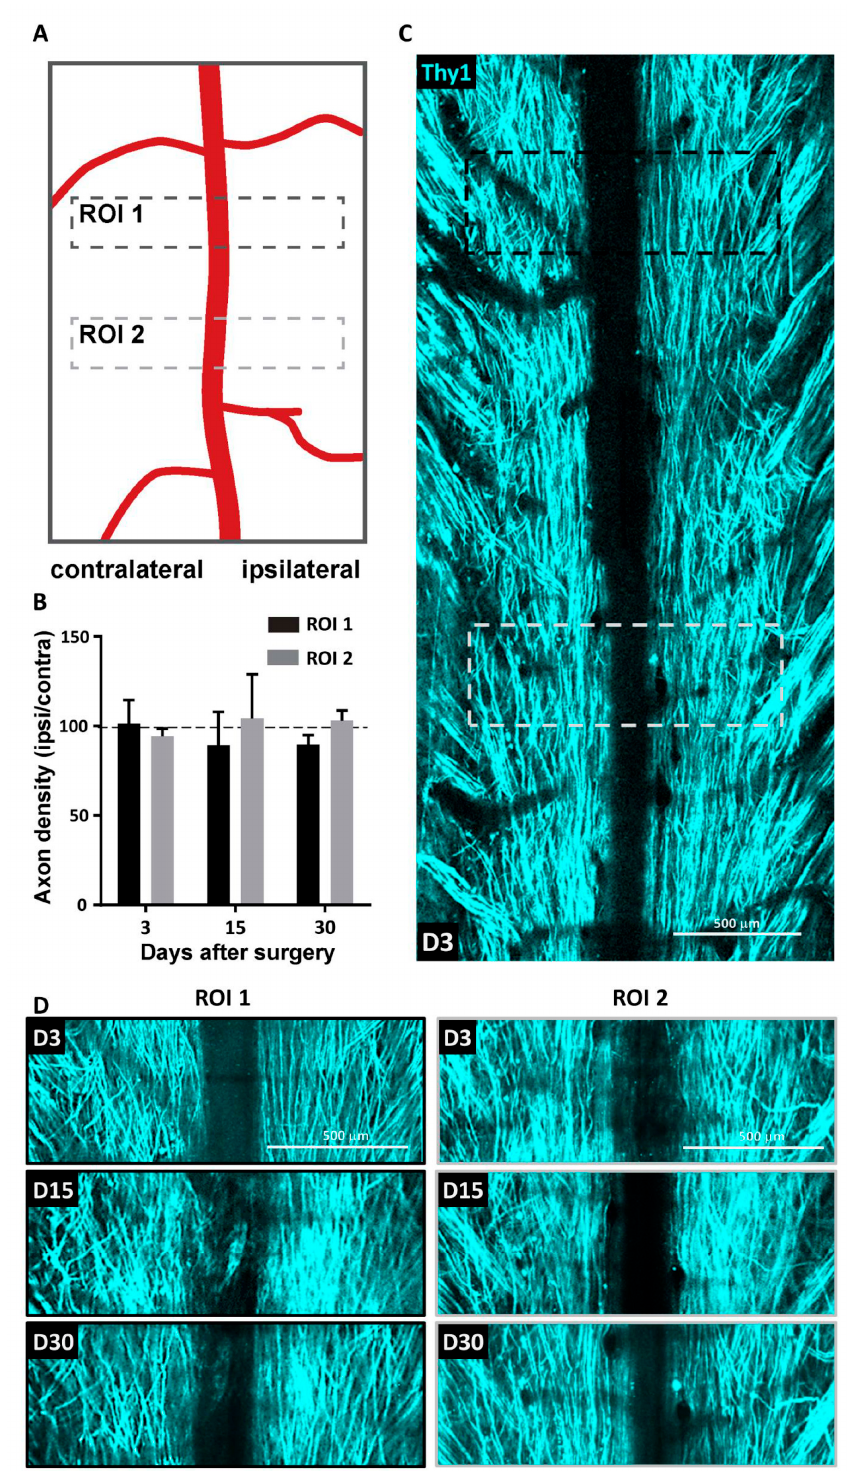
Figure 1. Spinal cord partial unilateral dorsal quadrant lesion (PUDQL) in Thy1 ‐ CFP mice. ( A ) Schematic view of the PUDQL (shadowed area in black). ( B ) Cresyl violet staining of transversal spinal cord section collected three days (D3) after window implantation or after PUDQL followed by window implantation. ( C ) Two ‐ photon (2P) fluorescence images of spinal slices consecutive to the one of B). ( D ) Dorsal view of the same Thy1 ‐ CFP spinal cord imaged through the implanted window showing the primary lesion area (dotted lines) and examples of subsequent Wallerian degeneration of axons (arrows) on D3. D: dorsal; V: ventral.